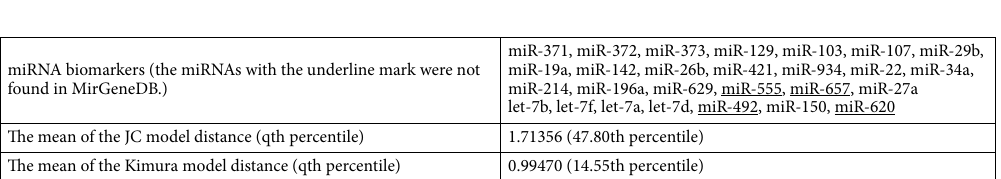
Table 6. The pairwise distance of the miRNA biomarkers of anti-NMDA receptor encephalitis and tumors.